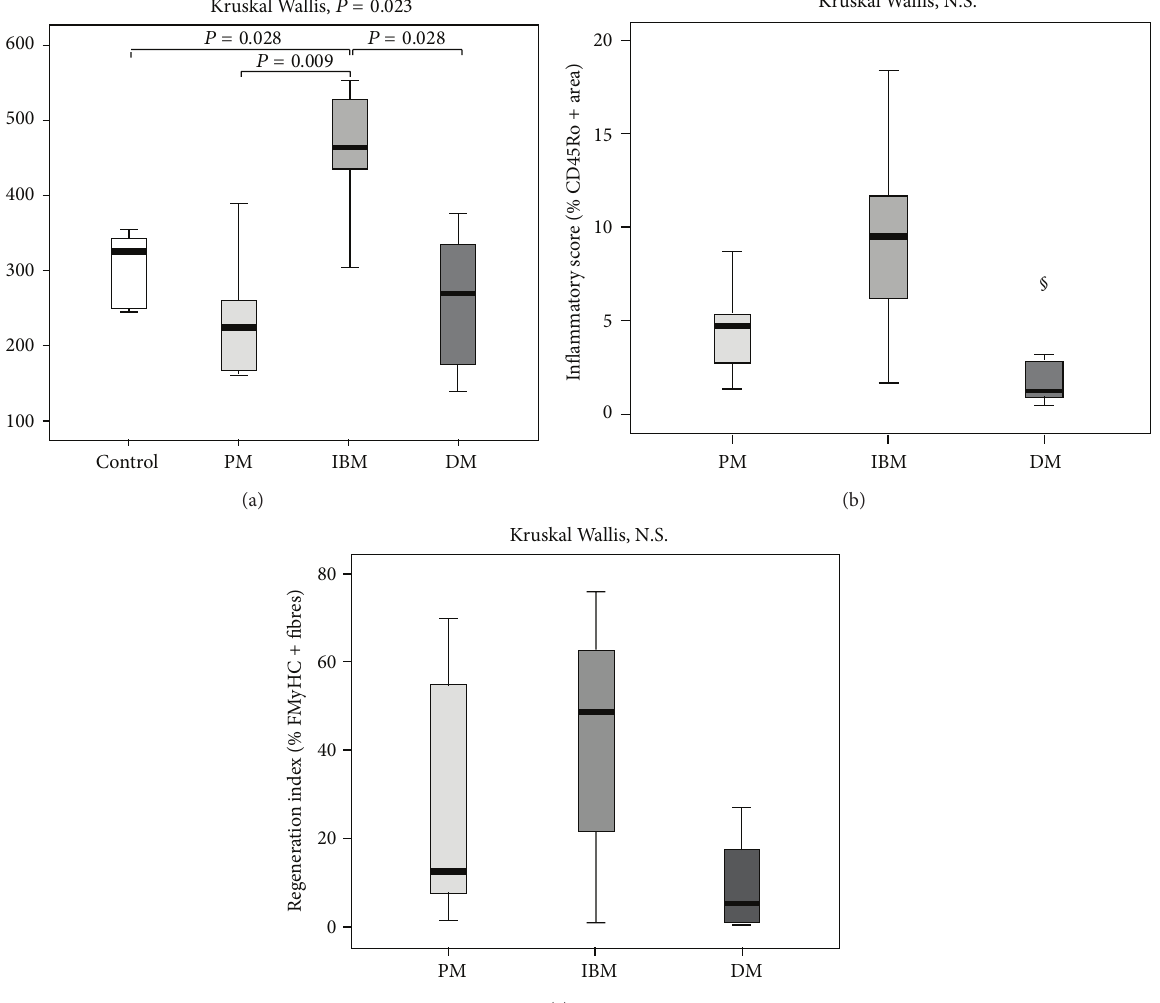
Figure 5: Quantitative analysis of pathological parameters in inflammatory myopathies. (a) A significant increase of the vessels density in IBM cases is detected. PM and DM cases showed a mild decrease of vessel density. (b) IBM cases showed the highest inflammatory score. § The DM outlier, with an unusually high inflammatory score, is a case of severe paraneoplastic DM, with high degree of myofiber necrosis and inflammation. (c) Regeneration index: the occurrence of regeneration showed a high variability among subjects, within the IIM subsets. The values are reported as means ± SD. All the statistical significant differences were